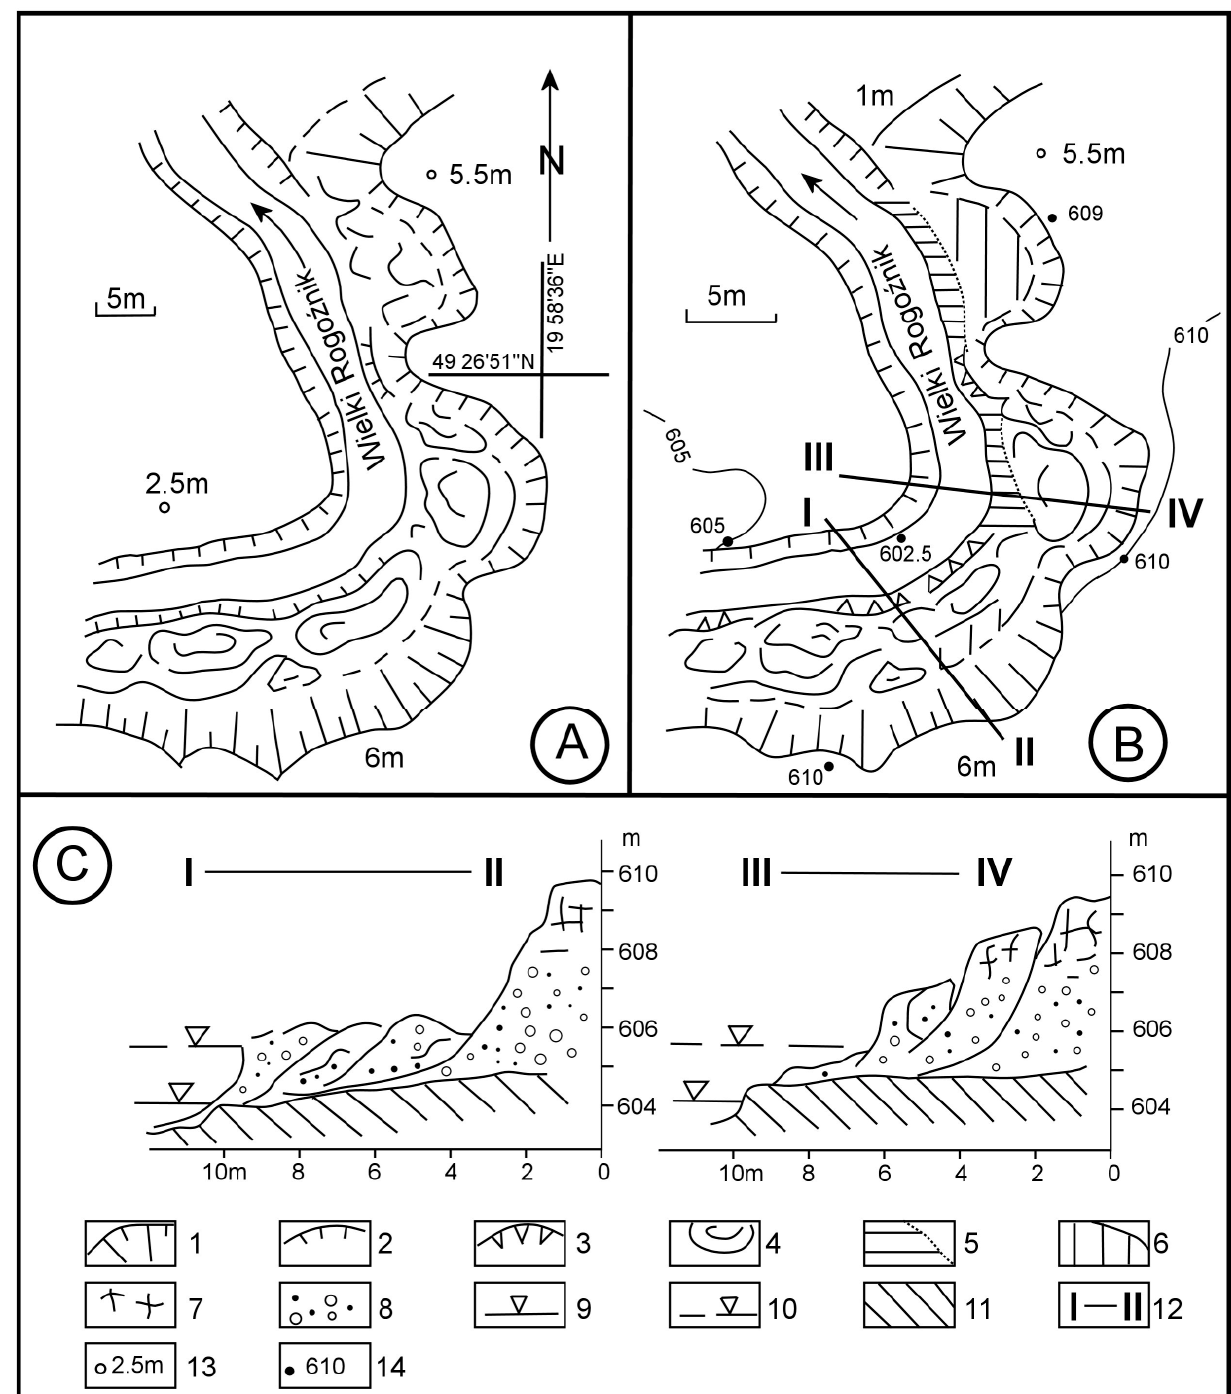
Figure 9. Transformation of the C-RCZ at site 2 in years 2013–2019; ( A )—plan of the landslide and river channel in 2019; ( B )—various modes of the C-RCZ modification and their location; ( C )—cross- sections through the landslide and its C-RCZ; 1—landslide main scarp, 2—stable undercutting at the channel bank, 3—erosional undercutting of colluvium, 4—colluvial ridges, 5—part of colluvium flooded during high river stages, 6—surface of the landslide undergoing rejuvenation, 7—silt cover on the 6–7 m terrace, 8—weathered crystalline gravel, 9—mean river stage, 10—high river stage, 11—Neogene claystones and mudstones, 12—cross-section lines, 13—relative height, 14—m a.s.l.